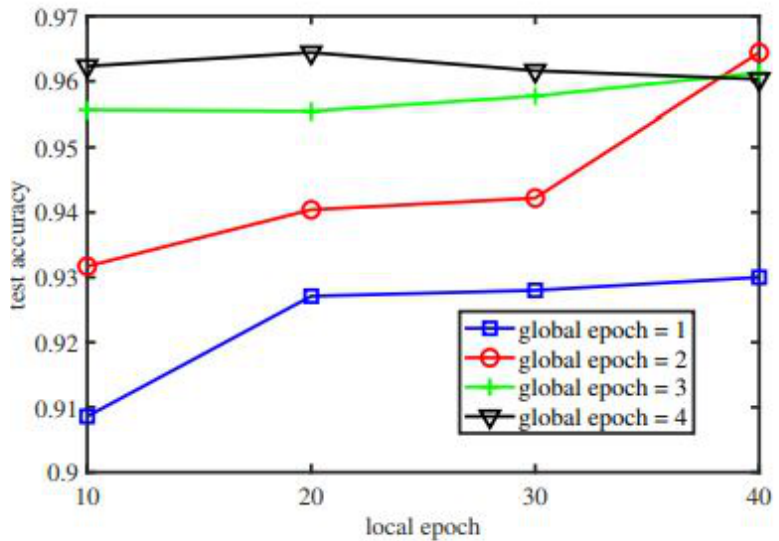
Figure 9. Performance comparison of the proposed framework and